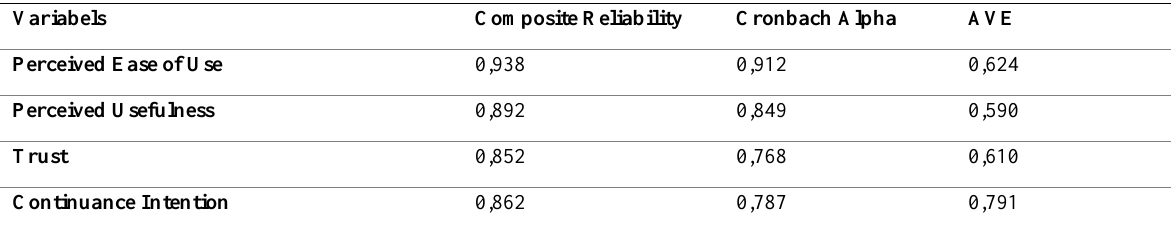
Table 1 indicates that the scale, magnitude and suitability of the statistics have been accepted. The average variance extracted (AVE) value of all latent variables shows a score of 0.624 for the perceived ease of use variable, 0.590 for the perceived usefulness variable, 0.610 for the trust variable, and 0.791 for the continuance intention